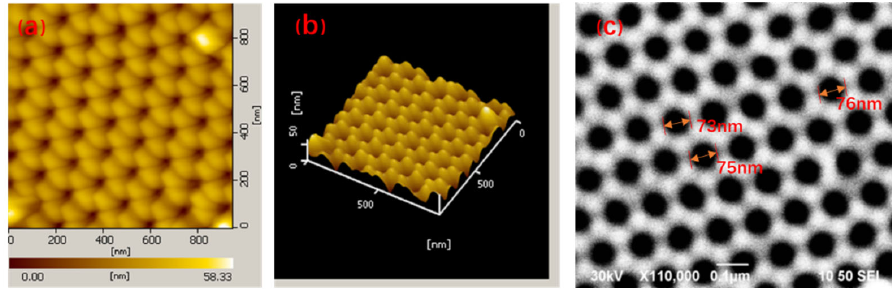
Figure 2. Surface topography of gold nanoporous arrays substrate: ( a ) 2D AFM image of gold nanoporous arrays; ( b ) three ‐ dimensional AFM image of nanoporous arrays; ( c ) SEM image of nanoporous arrays.